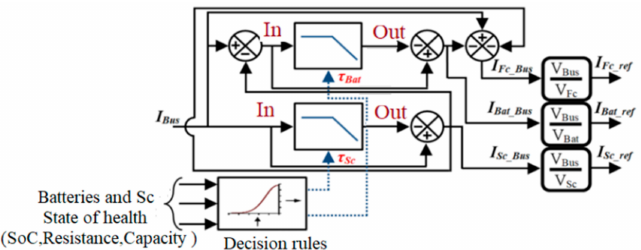
Figure 9. Principle of high, average, and low components extraction from the load’s current.